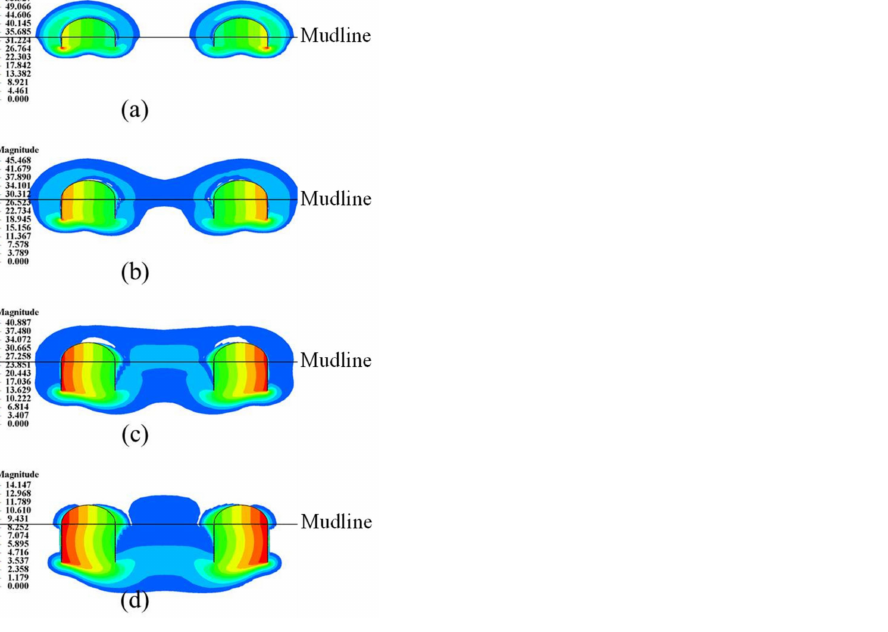
Figure 18. The magnitude of displacement contours of tetrapod bucket foundations and soils under ultimate moment loading at s/D = 2.0 and κ = 10 when ( a ) d/D = 0.25, ( b ) d/D = 0.5, ( c ) d/D = 0.75 and ( d ) d/D = 1.0.